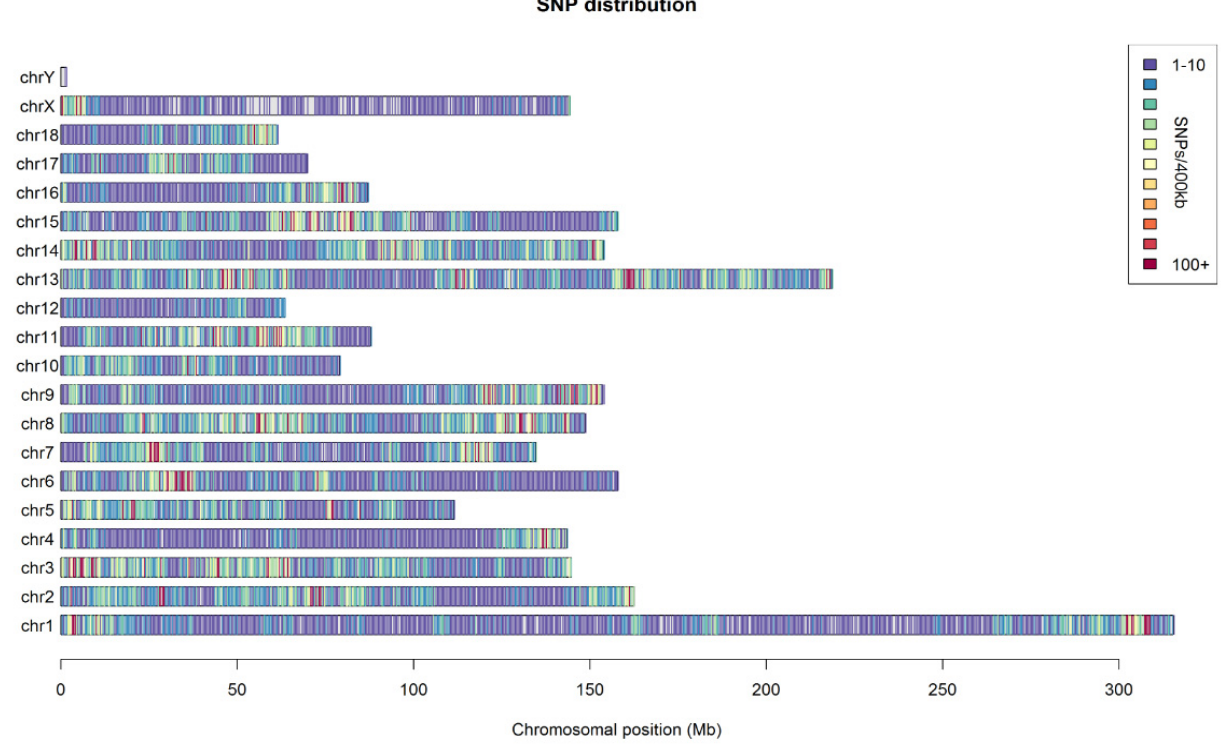
Figure 1. Distribution of the sequenced SNPs on all chromosomes. The y–axis represents chromosomes, and the x–axis represents the corresponding. Chromosomal position (Mb). Different colors of each 100 kb genome block denote the number of SNPs.